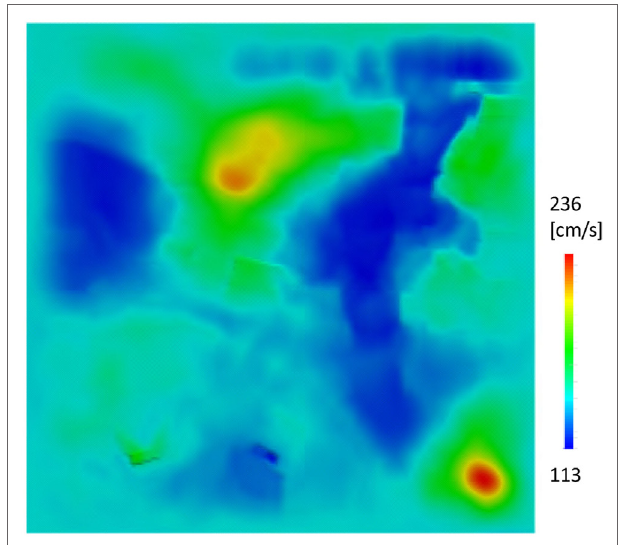
FigUre 7 | Distribution of